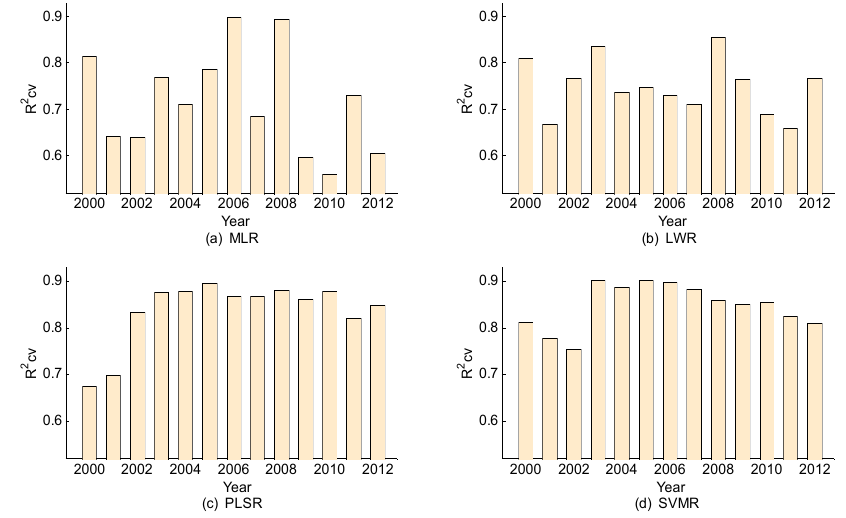
Figure 3 . (cid:1844) (cid:2870) (cid:1855)(cid:1874) for different data mining methods: ( a ) MLR; ( b ) LWR; ( c ) PLSR; and ( d ) SVMR. Figure 3. R 2 cv for different data mining methods: ( a ) MLR; ( b ) LWR; ( c ) PLSR; and ( d )